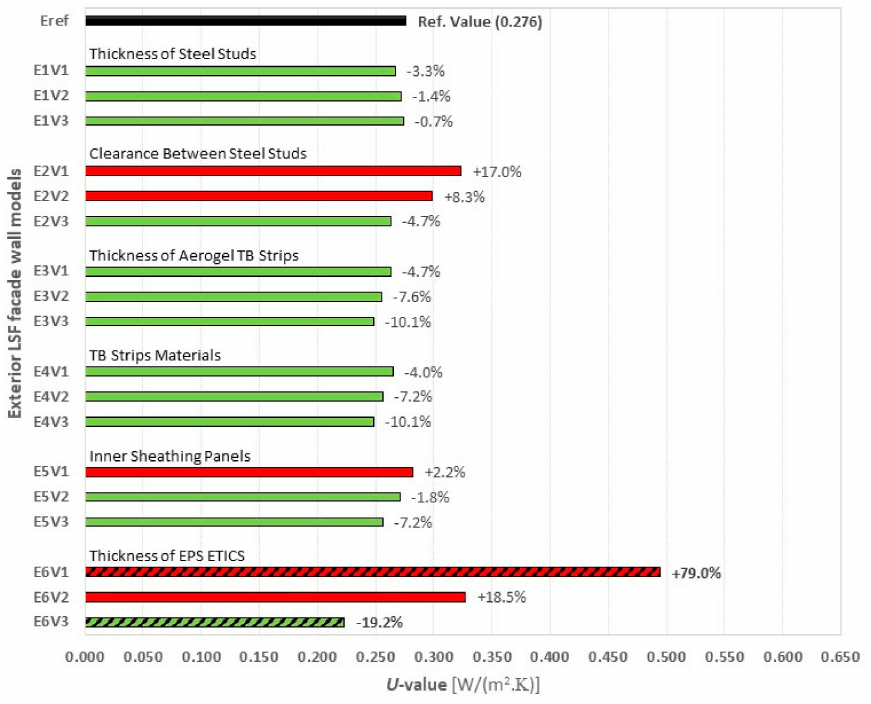
Figure 9. Thermal transmittances obtained for exterior LSF facade